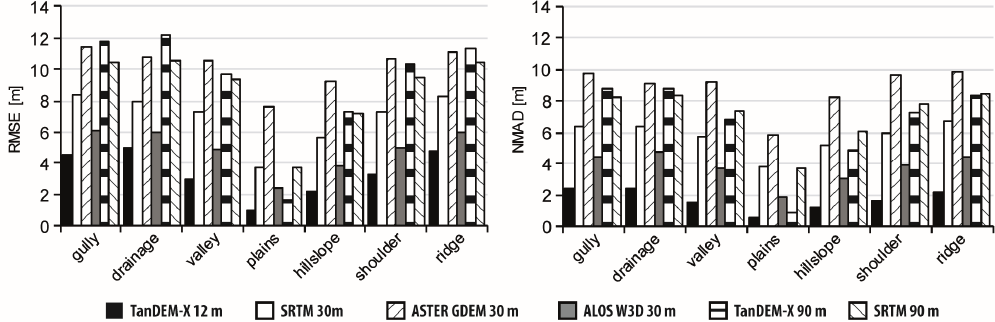
Figure 8. Calculated RMSE and NMAD of elevation according to topographic position index (TPI) classes classified with 12 m